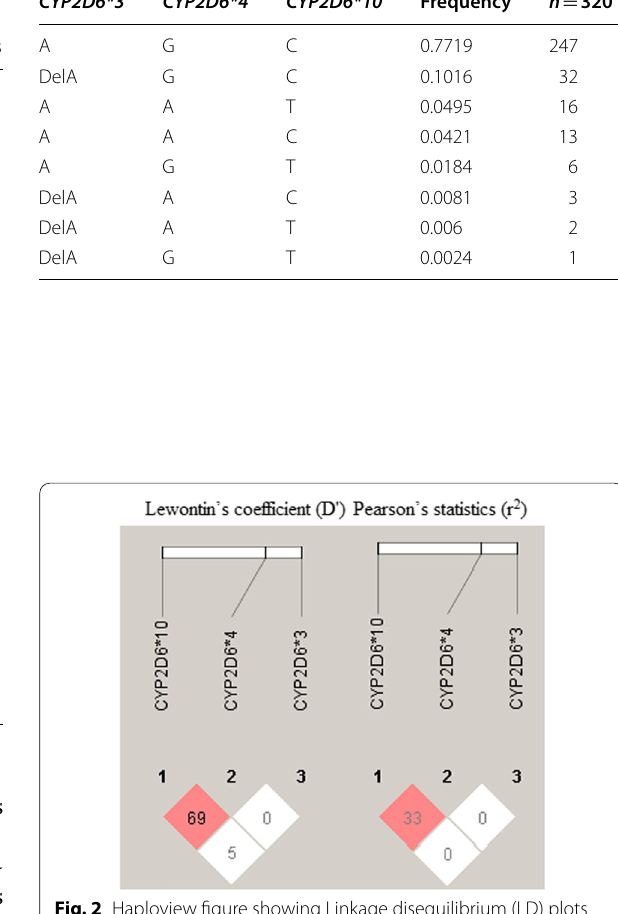
Table 4 Haplotypes frequencies of the CYP2D6 ( CYP2D6*3/ Allelic and Genotypic Frequencies